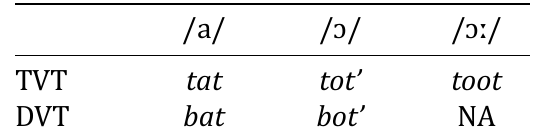
Table A.3: C₂ fortis plosive in monosyllables